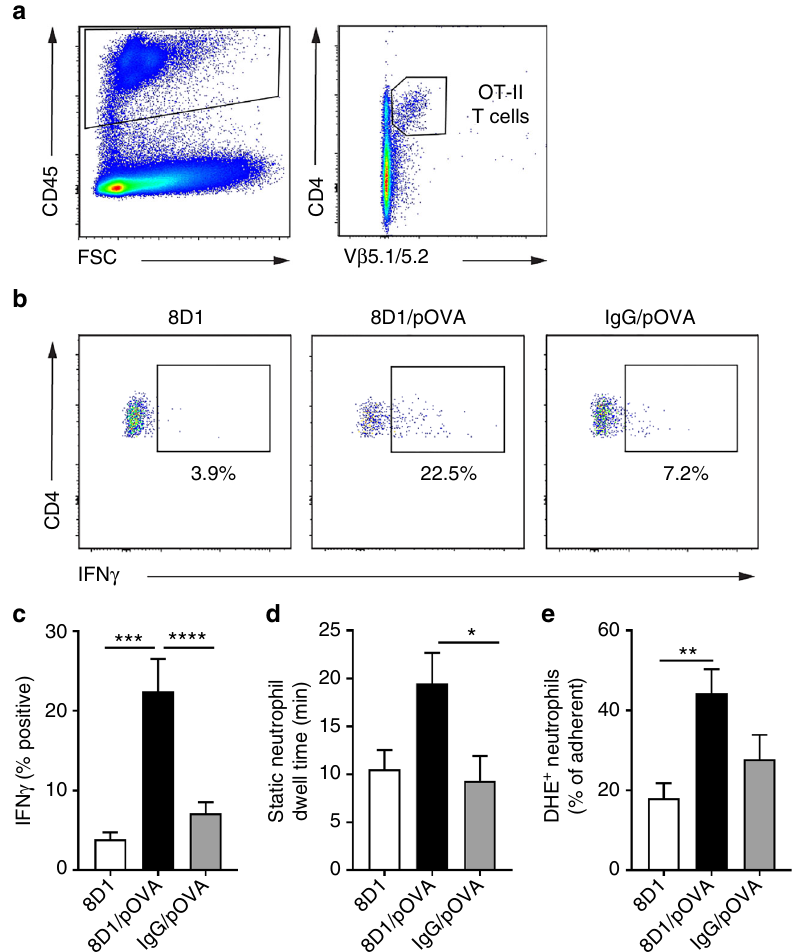
Fig. 5 Glomerular targeting of pOVA promotes T-cell activation and glomerular in fl ammation. a – c Assessment of OT-II cell activation in the kidney in the presence of glomerulus-targeting antibody alone (8D1), glomerulus-targeted antigenic peptide (8D1/pOVA), or non-targeted antigenic peptide (IgG/pOVA). a , b Example fl ow cytometry data showing gating strategy to detect OT-II cells (left panel — forward scatter/CD45 + ; right panel — CD4 + V β 5.1/5.2 + ) in kidney digests ( a ), followed by intracellular staining for IFN γ in all three experimental conditions ( b ). c Group data showing IFN γ expression (as % of OT-II cells) from mice receiving either 8D1, 8D1/pOVA or IgG/pOVA along with OT-II cells. Data are shown as mean ± s.e.m. of n = 7 (8D1) or 8 (8D1/pOVA and IgG/pOVA) mice per group. *** P < 0.001; **** P < 0.0001, via one-way ANOVA with Dunnett ’ s multiple comparison test. d , e Neutrophil retention and activation in the glomerulus in the presence of 8D1, 8D1/pOVA or IgG/pOVA, as assessed by multiphoton microscopy. Data are shown for static dwell time ( d ) and % of adherent neutrophils that were DHE + ( e ). Data are shown as mean ± s.e.m. of n = 8 (8D1 and IgG/pOVA) or 10 (8D1/pOVA) mice per group. * P < 0.05; ** P < 0.01, via one-way ANOVA with Tukey ’ s multiple comparison test ( d , e